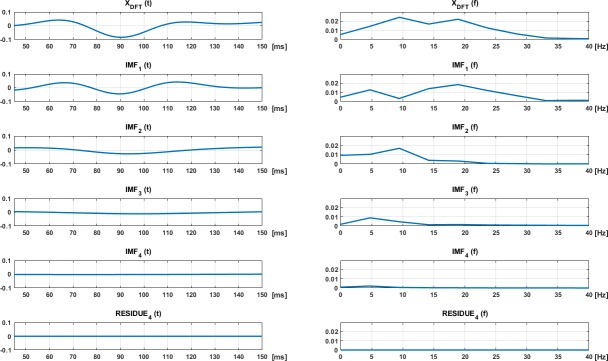
EMD and residues obtained when all the signals in the control database are averaged.Time (left) and frequency (right).